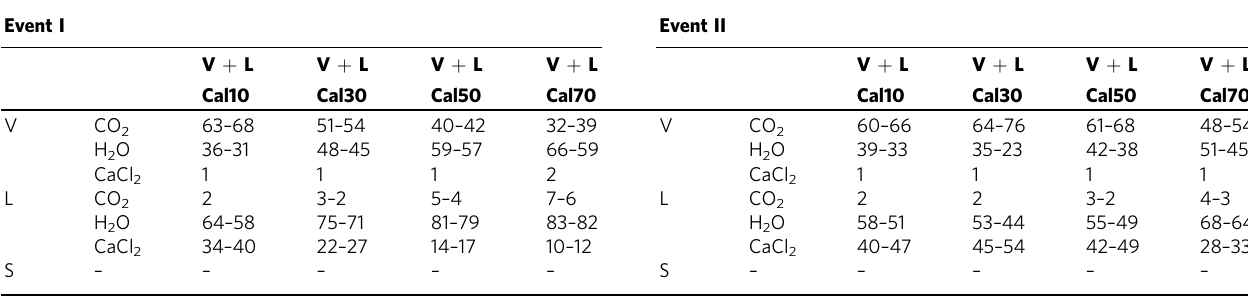
Table 3 Compositional ranges (mol%) of immiscible fl uids generated by each modeled bulk composition (Cal10, Cal30, Cal50, Cal70) during event I and event II in the H 2 O – CO 2 – CaCl 2 system.